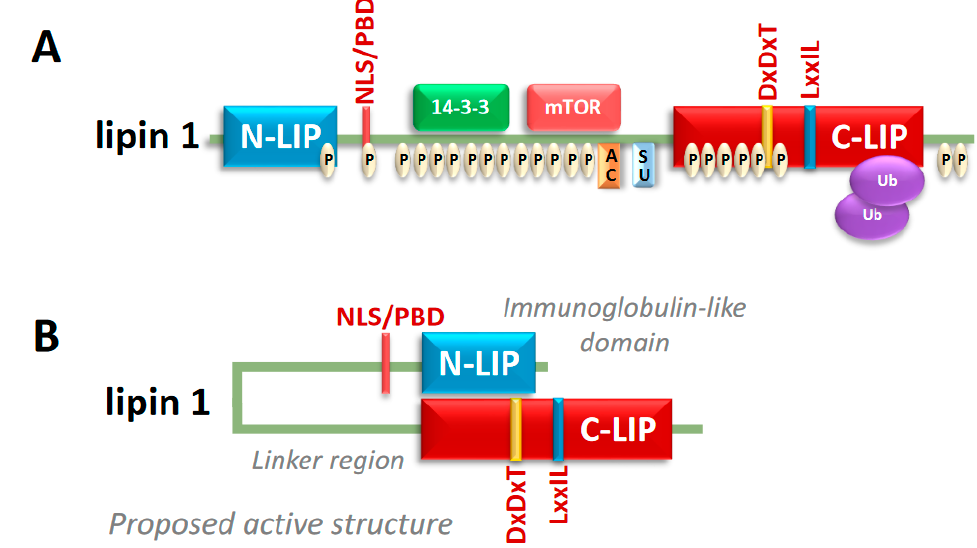
Figure 2. Lipin 1 structure and posttranslational modifications. ( A ) The lipin 1 protein contains several serine and threonine phosphorylation sites (P). Additionally, lipin 1 is acetylated (AC), sumoylated (SU), and ubiquitinated (Ub). Lipin 1 contains highly conserved N-terminal lipin (N-LIP) and C-terminal lipin (C-LIP) domains. The nuclear localization signal (NLS) is within the poly basic domain (PBD). The haloacid dehalogenase domain (DxDxT) is the catalytic motif and the LxxIL motif are contained within the C-LIP domain. ( B ) Recent crystal structure data suggests the N-LIP and C-LIP domains, which are separated by a linker region, interact to form an immunoglobulin-like domain in the native